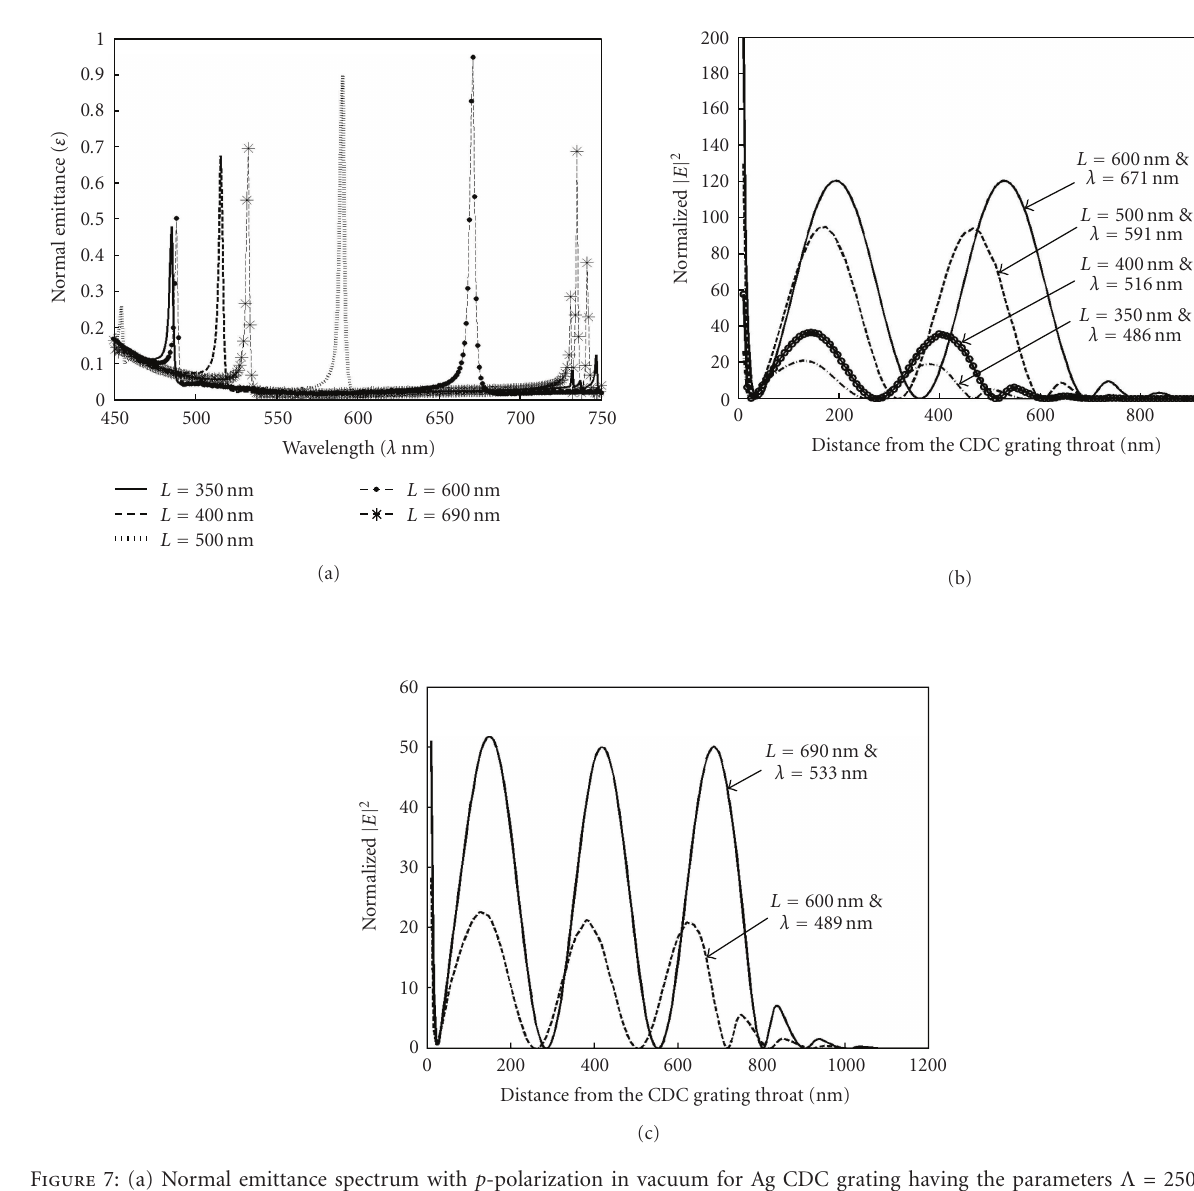
Figure 7: (a) Normal emittance spectrum with p -polarization in vacuum for Ag CDC grating having the parameters Λ = 250 nm, h = 100 nm, t = 100nm, g = 5nm, and a photonic crystal having the parameters a = 100 nm, d 1 = d 2 = 50 nm with varying cavity. Electric field intensity distribution normalized to the incident along the line passing through the center of the CDC grating throat and into the photonic crystal with (b) L = 350 nm, L = 400 nm, L = 500 nm, L = 600 nm, and at respective higher normal emissive peak wavelengths (c) L = 600 nm, L = 690 nm, and at respective lower-normal emissive peak